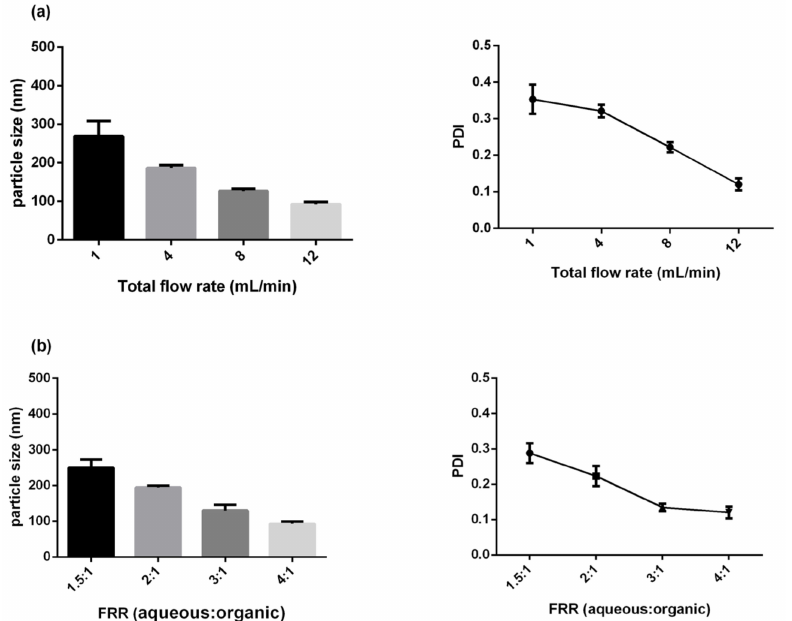
Figure 1. Characteristics of LNC-Dox: ( a ) Effects of TFR on particle size and PDI at a fixed FRR (4:1). ( b ) Effects of FRR on particle size and PDI at a fixed TFR (12 mL/min). Results are the mean ± SD obtained from three independent experiments ( n =